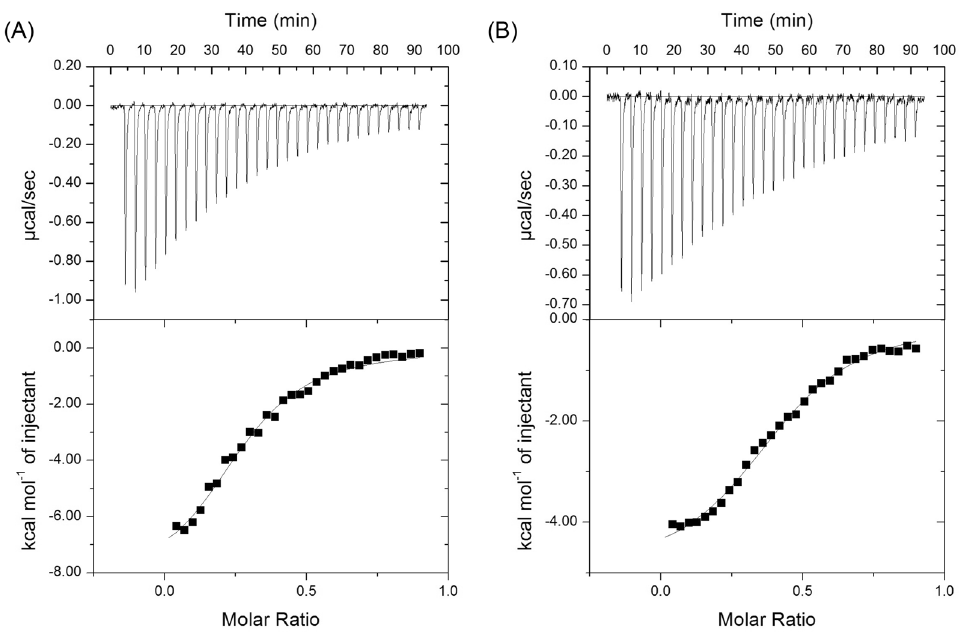
Figure 9. ITC curves obtained with the titration of ( A ) 1.0 mM CdCl 2 or ( B ) 1.0 mM ZnCl 2 to 0.1 mM AADAAC-F4 at 30 °C in Tris buffer at pH 8.0. ( A ) Fit line for Cd: n = 0.263 ± 0.016, K a = 1.38 (± 0.81) × 10 5 , Δ H = − 10.84 ± 1.03 kcal mol −1 , and Δ S = − 0.012 ± 0.003 kcal K −1 mol −1 . ( B ) Fit line for Zn: n = 0.354 ± 0.046, K a = 1.24 (± 0.71) × 10 5 , Δ H = − 6.82 ± 0.81 kcal mol −1 , and Δ S = 0.0004 ± 0.003 kcal K −1 mol −1 . The metal- dependent thermodynamics are summarized in Table